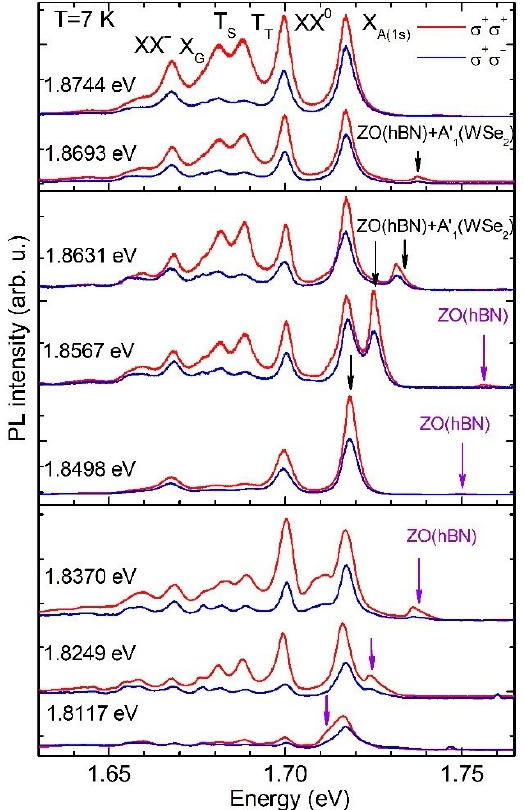
Figure 3. Helicity-resolved PL spectra recorded in two circular polarization configurations of ex- cited and emitted light: The same (co—polarized, σ + / σ + —red line) and opposite (cross-polarized, σ + / σ − —blue line) polarizations. Excitation energies are marked at the left corner of each spectrum. The energy positions of PL lines are marked in the upper panel. The Raman phonon modes ZO (hBN) + A ′ 1 (WSe 2 ) and ZO (hBN) are marked by black and violet arrows, respectively.